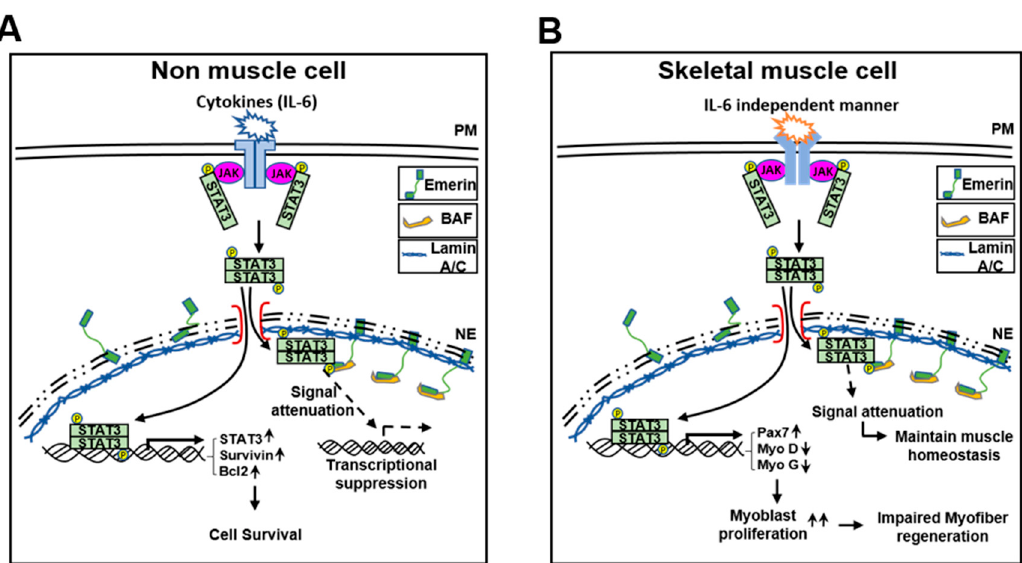
Figure 5. A schematic model describing the role of emerin in the STAT3 signaling pathway. ( A , B ) Emerin regulates STAT3 transcriptional activity on non-muscle cells or skeletal muscle cells.